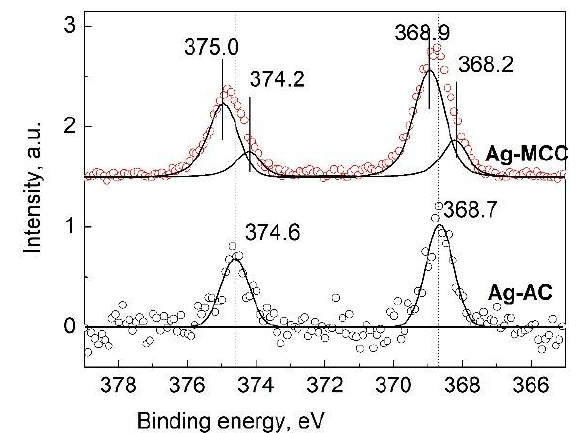
Figure 13. High resolution Ag 3d spectra of microcrystalline cellulose containing Ag NPs (Ag-MCC) and the corresponding aerogel (Ag-AC).